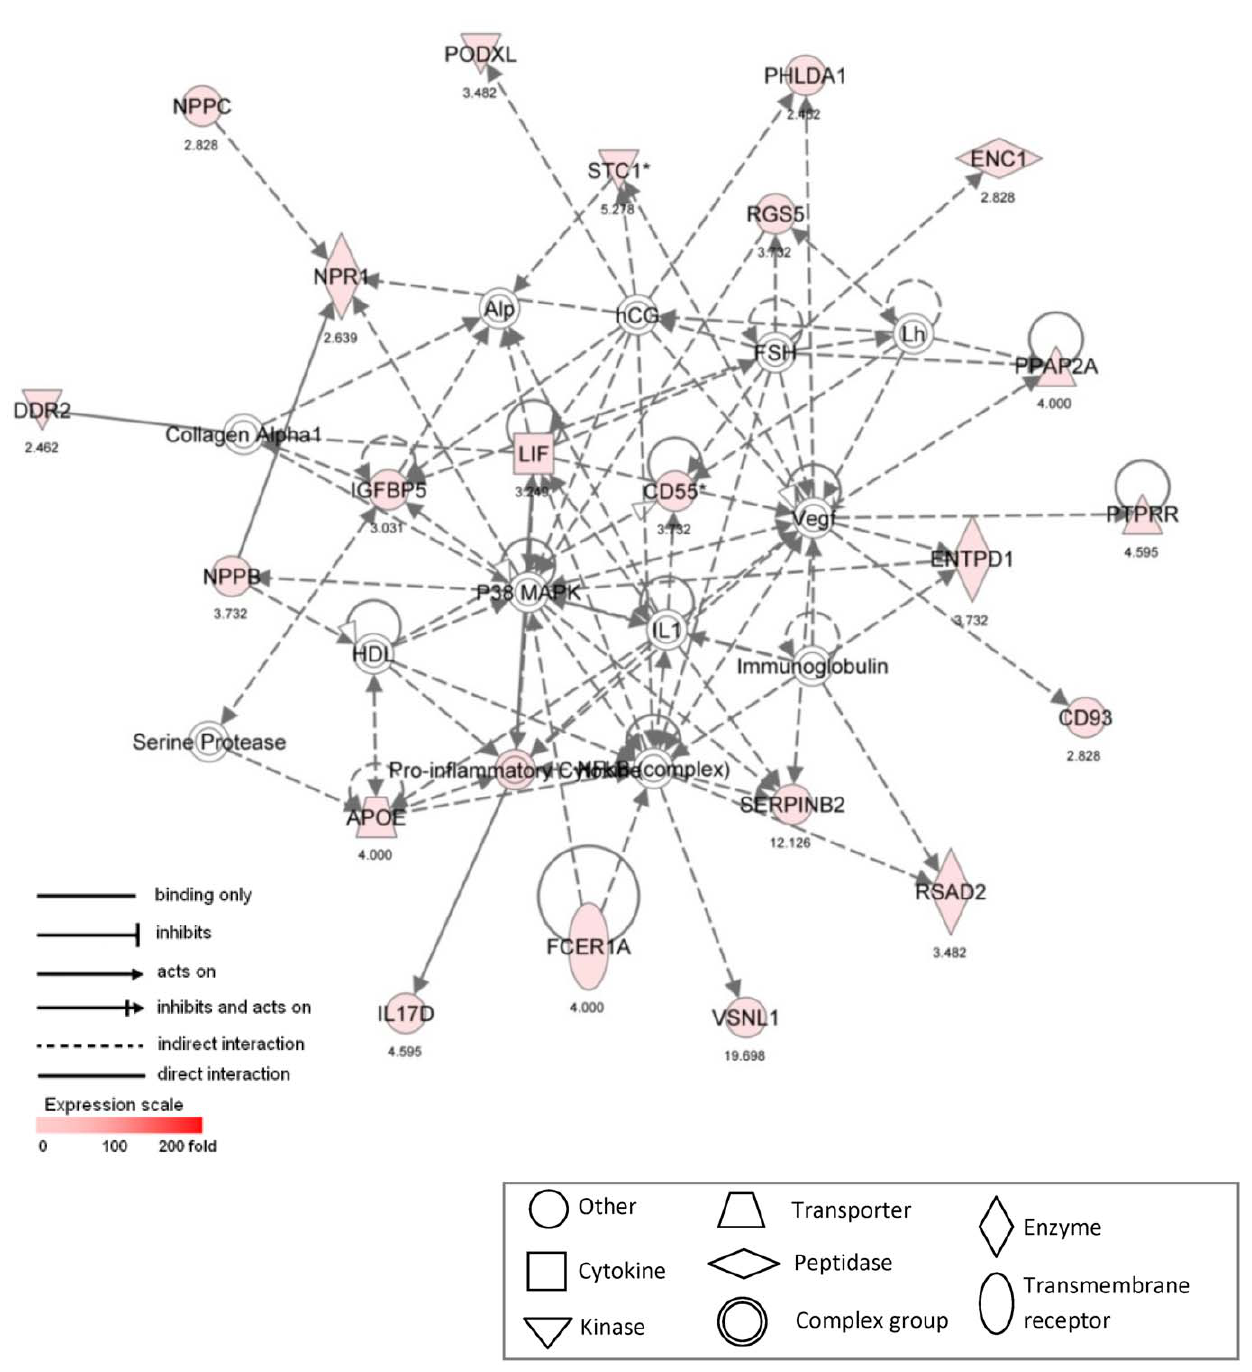
Figure 3. Ingenuity pathway analysis Network # 1. Ingenuity pathway analysis was used to assemble a network based upon 22 differentially expressed focus genes that were upregulated in male VICs compared to female VICs. Genes are represented as nodes, with node shape representing the functional class of the gene product (seen in legend). Node color depicts degree of overrepresentation in male samples; uncolored nodes are depicted based upon evidence in the IPA Knowledge Base indicating a strong biological relevance to the network. *indicates multiple identifiers in the dataset file map to a single gene in the IPA Global Molecular Network. Corresponding fold change values are listed beneath each gene label. Focus gene names are defined in Table S1.